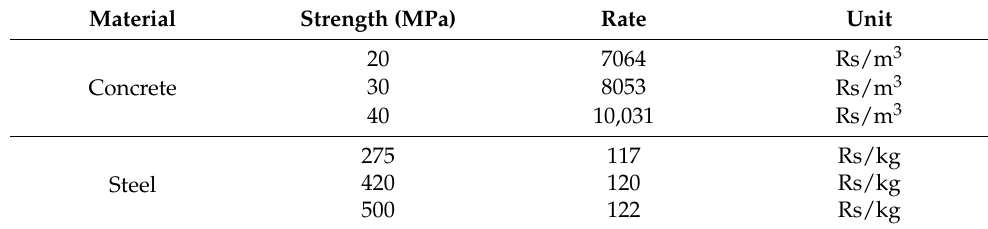
Table 10. Rates of materials used for parametric study.